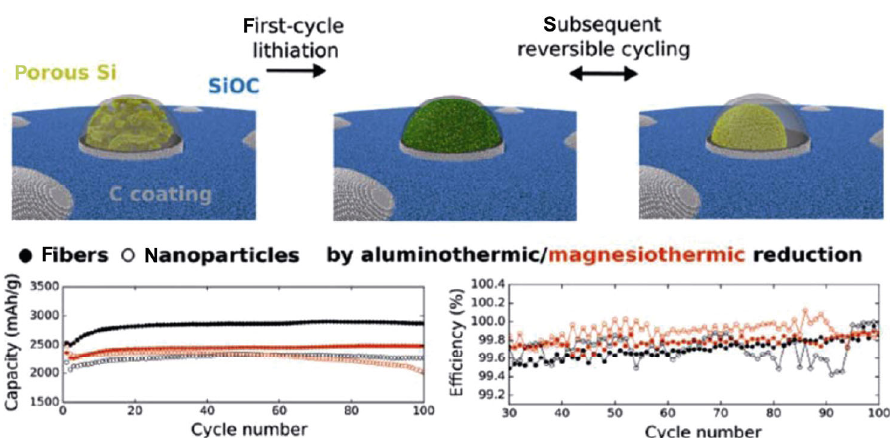
Fig. 21 Schematic diagram of mechanism of lithiation/delithiation of porous nano Si in a C/SiOC matrix and its electrochemical performance. Reproduced with permission from Ref. [110], © American Chemical Society 2017. silicon crystallinity on the performance of the